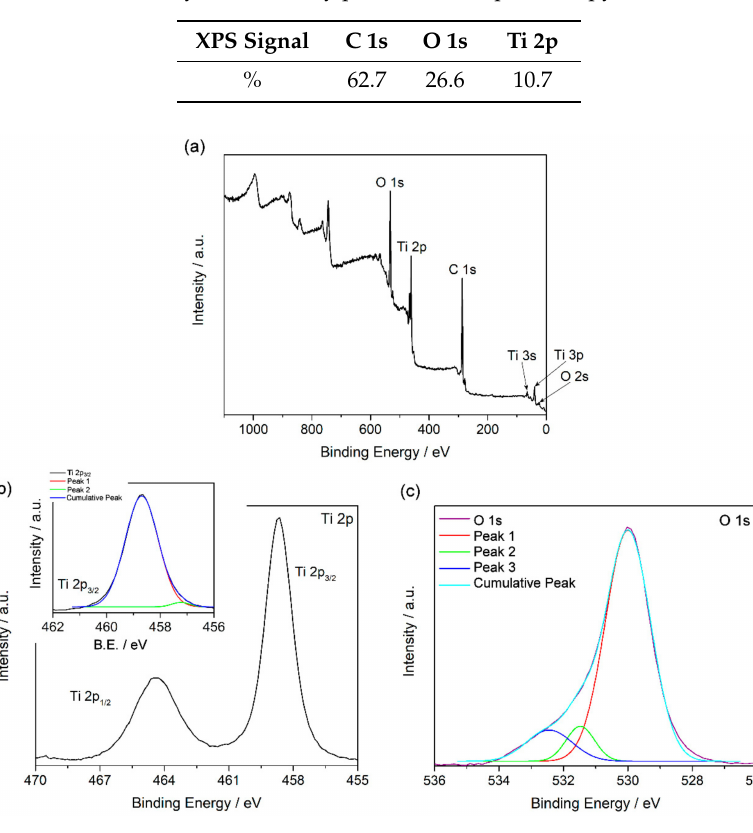
Table 2. Quantitative analysis from X-ray photoelectron spectroscopy (XPS) measurements.